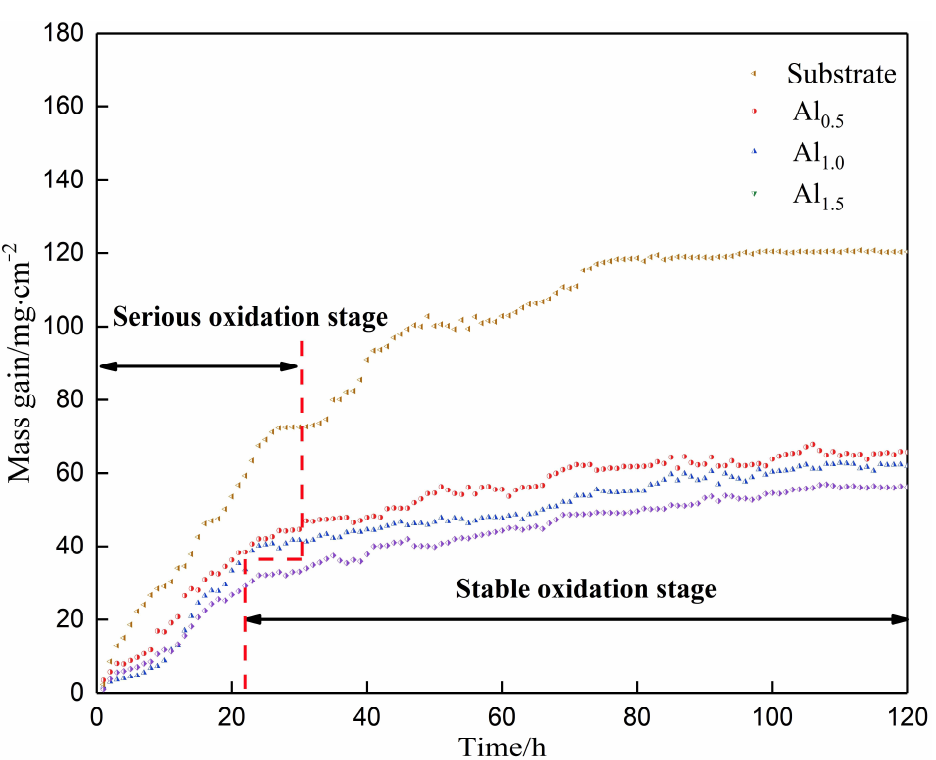
Figure 11. Oxidation mass gain curves of the substrate and the coatings after exposed to 1000 °C in air for 120 h.